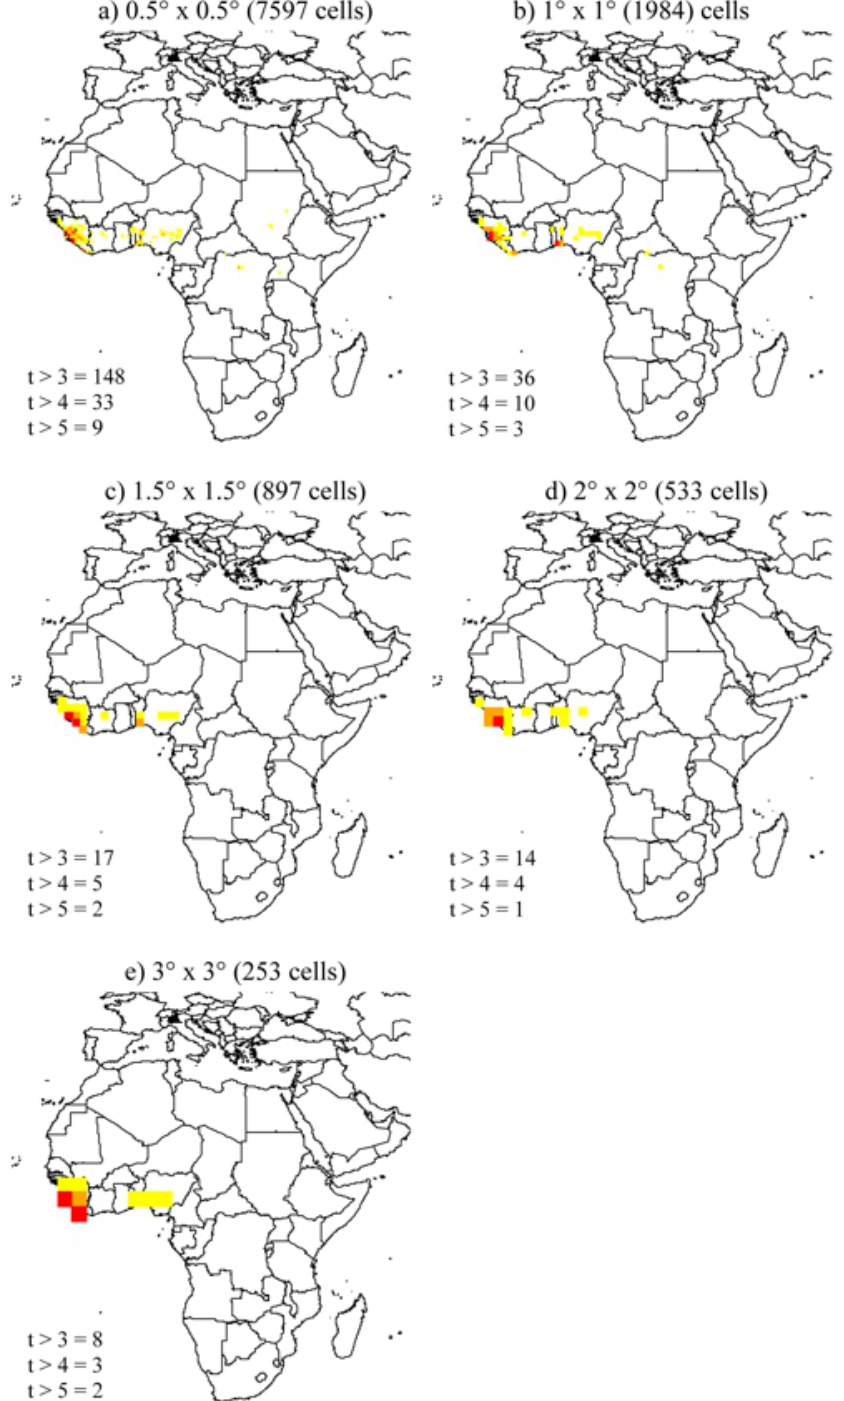
Fig. 2. Areas where NDVI significantly predicted population trends of Common House-Martin based